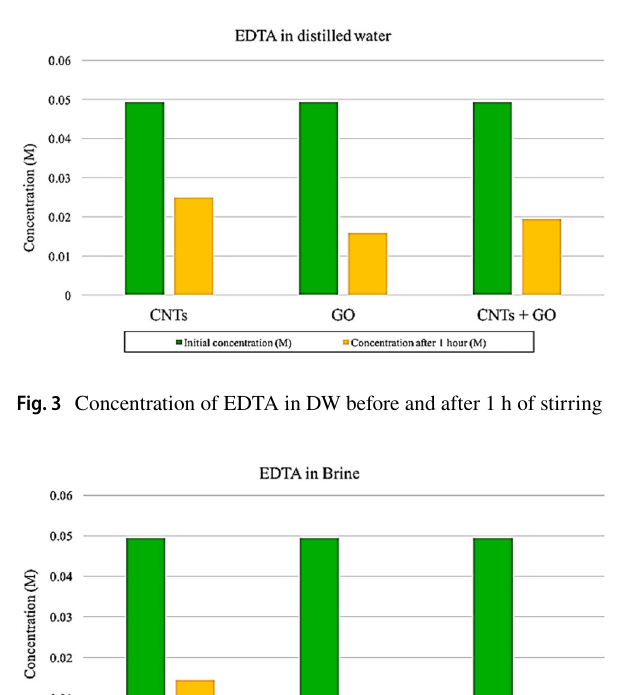
Fig. 5 Concentration reduction (%) in EDTA in different nanomateri- als and background